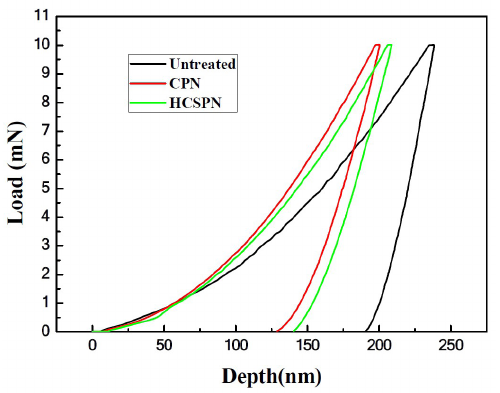
Figure 7. Typical loading–unloading curves of the different samples measured by nano-indentation tester.